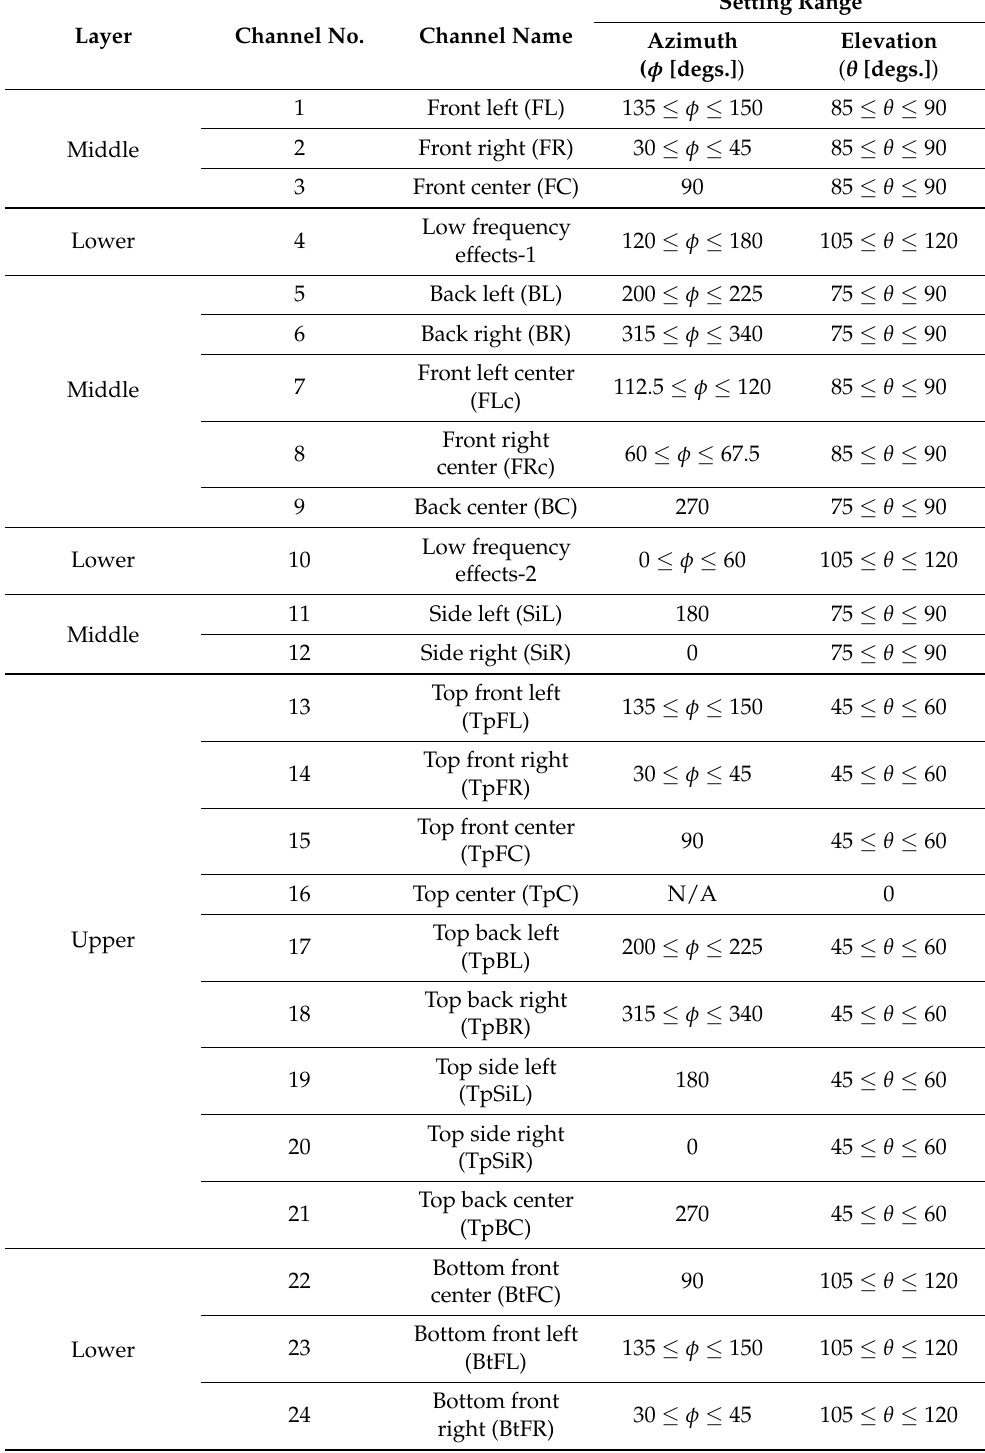
Table 1. Requirement of loudspeaker arrangement in a 22.2 multichannel